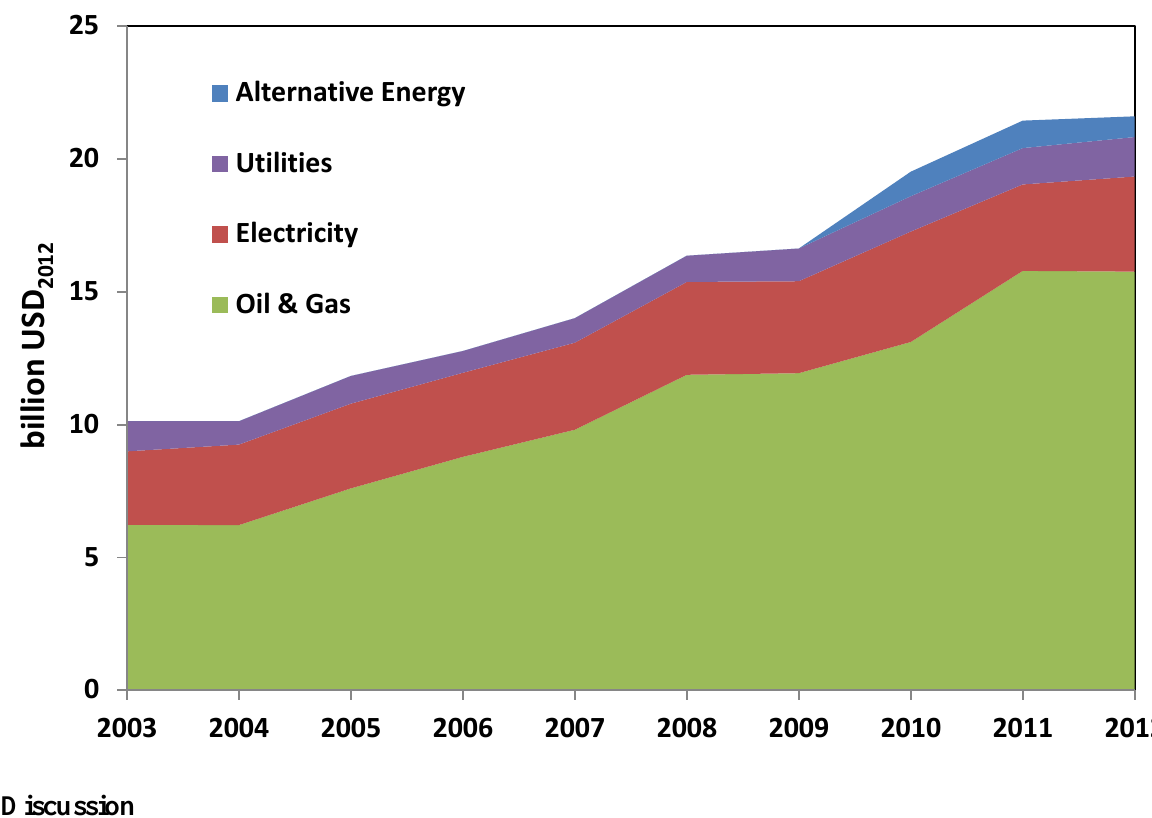
annually on 2012